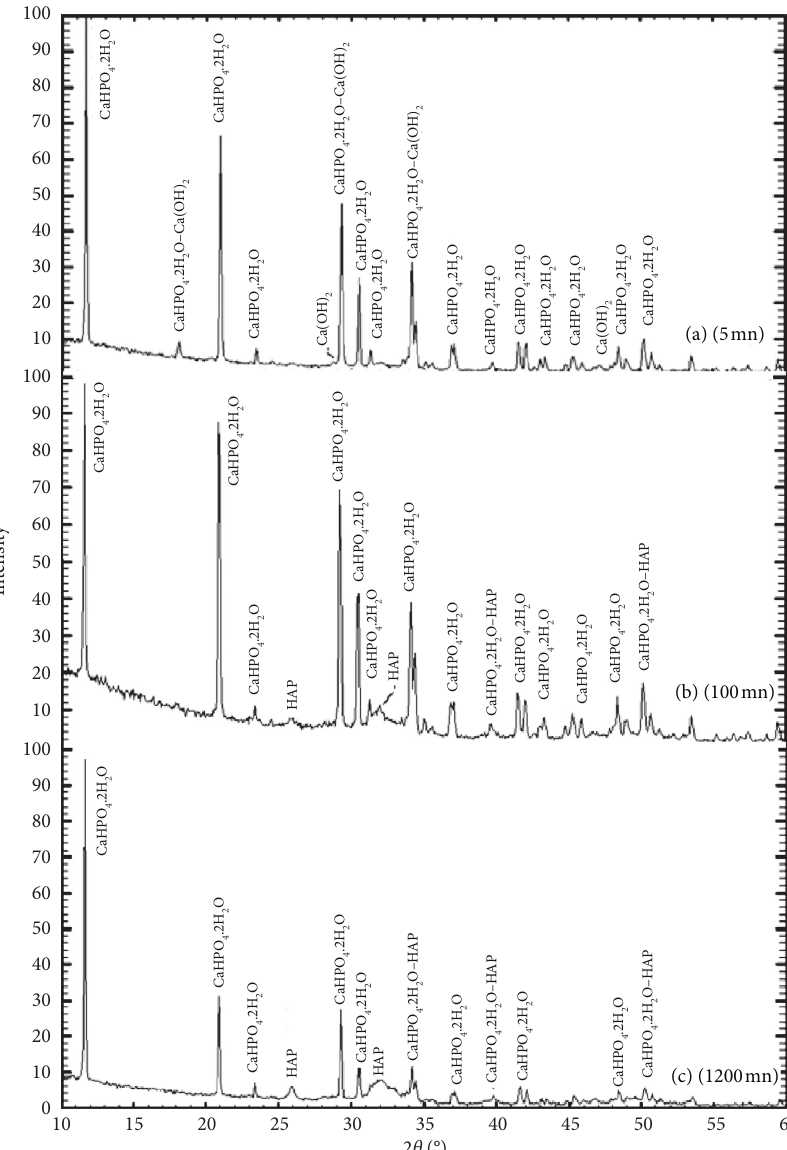
Figure 5: X-ray diagrams of the solid phase taken from the M 2 mixture as a function of time: (a) at 5min, (b) at 100 min, and (c) at 1200min.